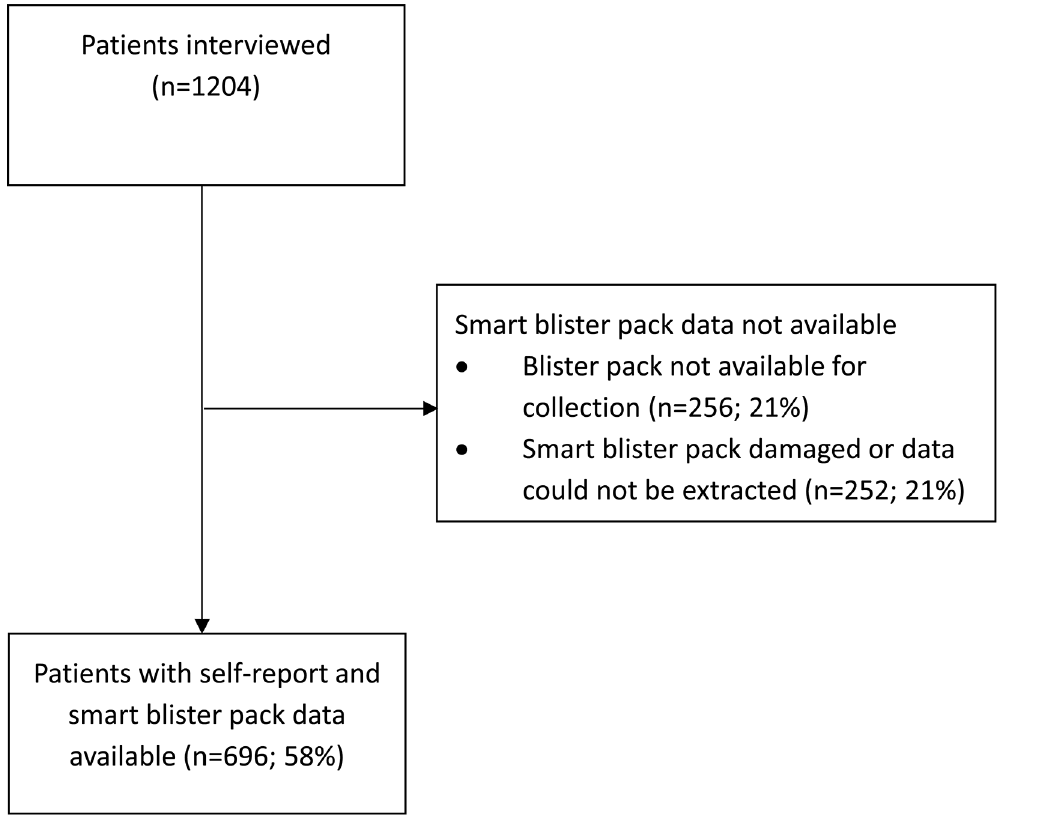
Fig 2. Flow chart of patients included in